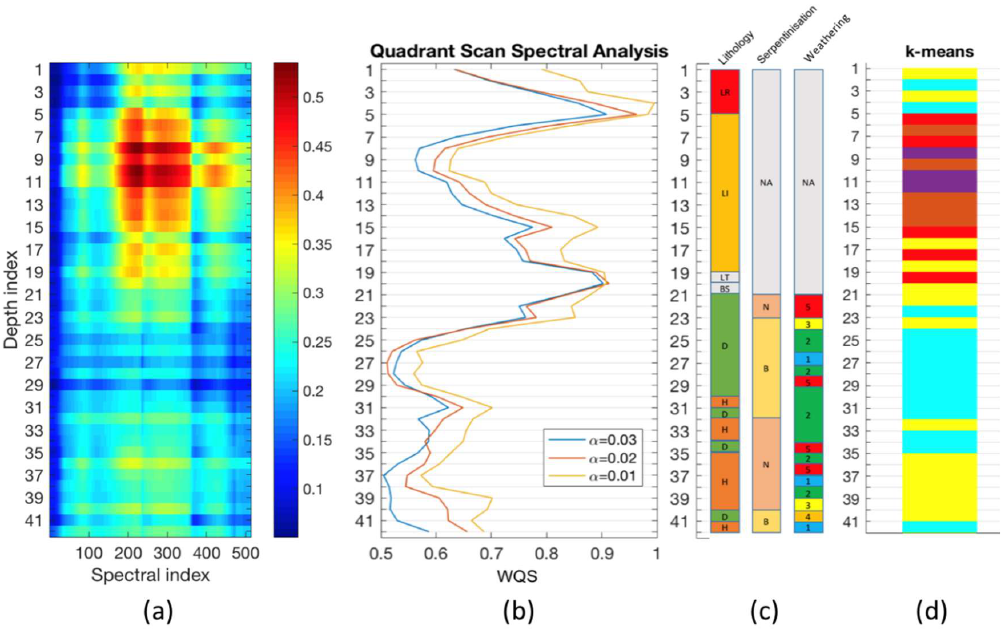
Figure 6. OUACO drill-hole. ( a ) Heatmap plot of depth index against spectral index (blue colours reflect low values and red colours reflect high values); ( b ) Weighted quadrant scan results from the spectral data using three different values of 𝛼 , peaks indicate lithological boundaries; ( c ) The boundaries identified manually by domain experts (see Table 1 for geology logging codes), and; ( d ) Results of k-means clustering with k = 8 (the different colours represent different clusters).